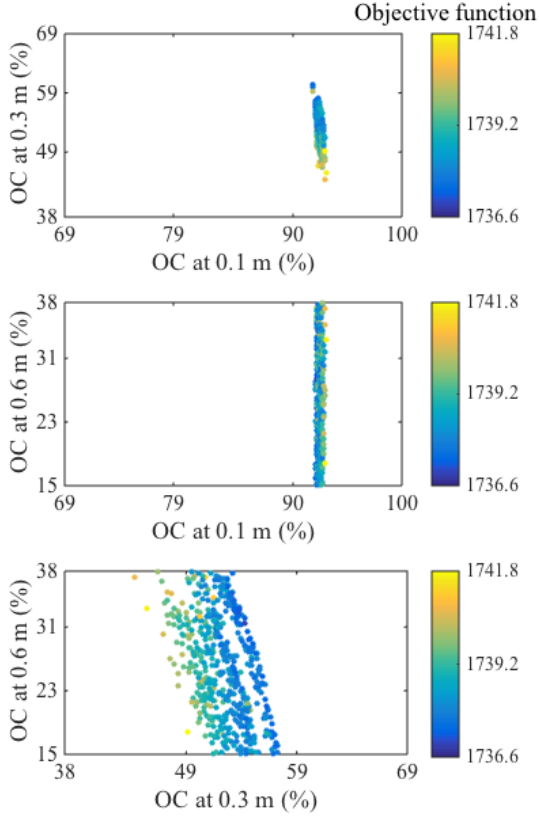
Figure 7. Misfit (sum of square of absolute difference) between synthetic observations and MCMC sampling apparent resistivity data as a function of soil OC content at z = 0 . 1, 0.3 and 0.6m for scenario